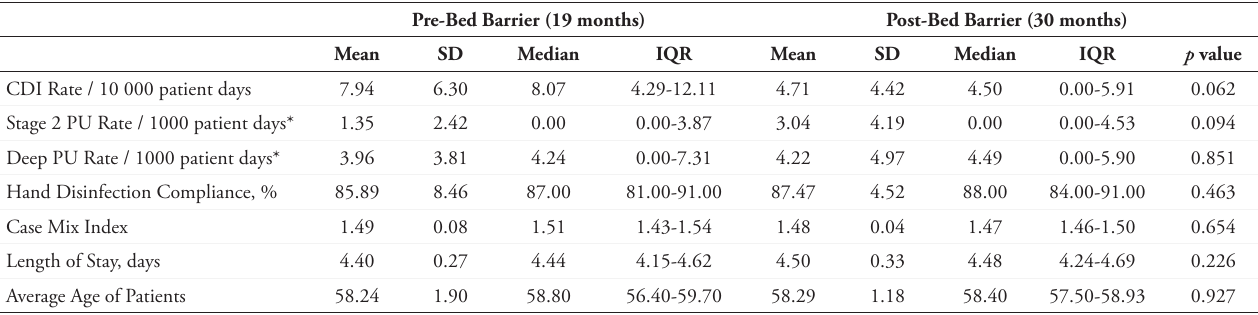
Table 1: Descriptive statistics for HO-CDI, Hand disinfection, Acuity, Age, and Length of Stay